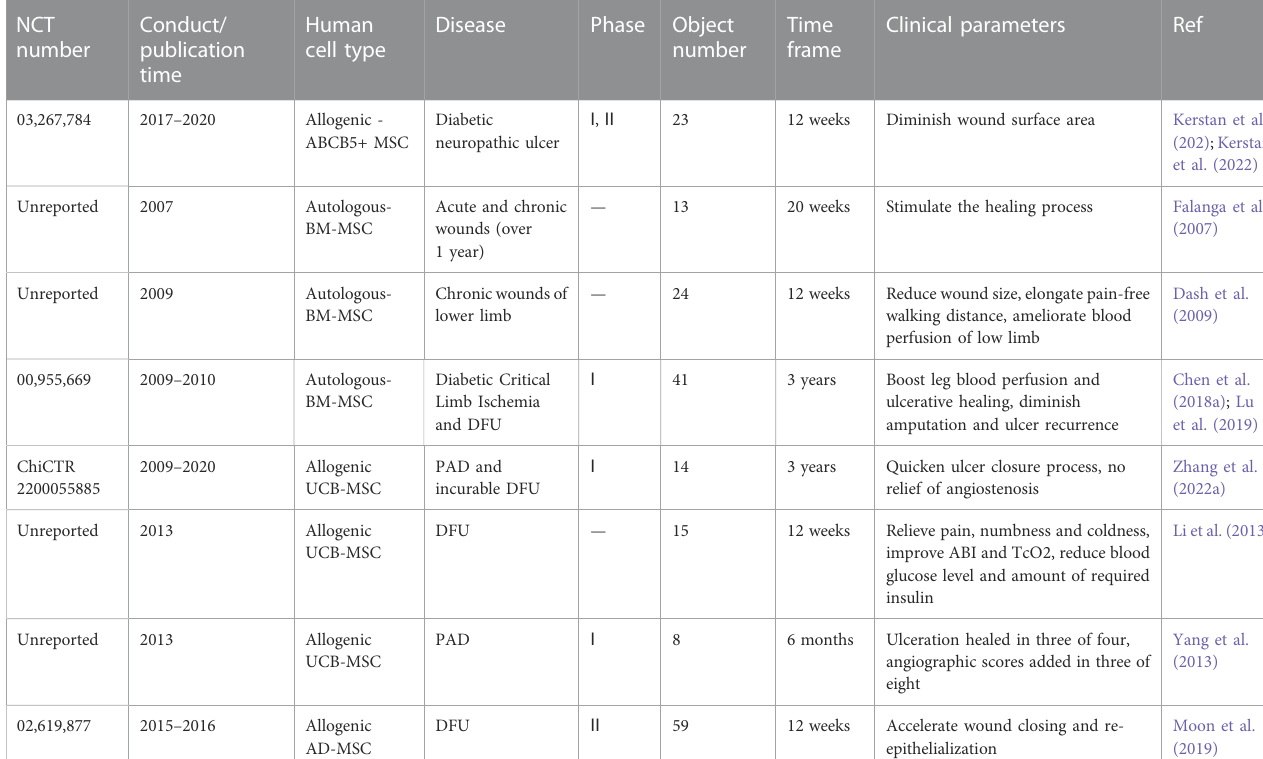
TABLE 2 Clinical trials of MSC therapy in skin non-healing